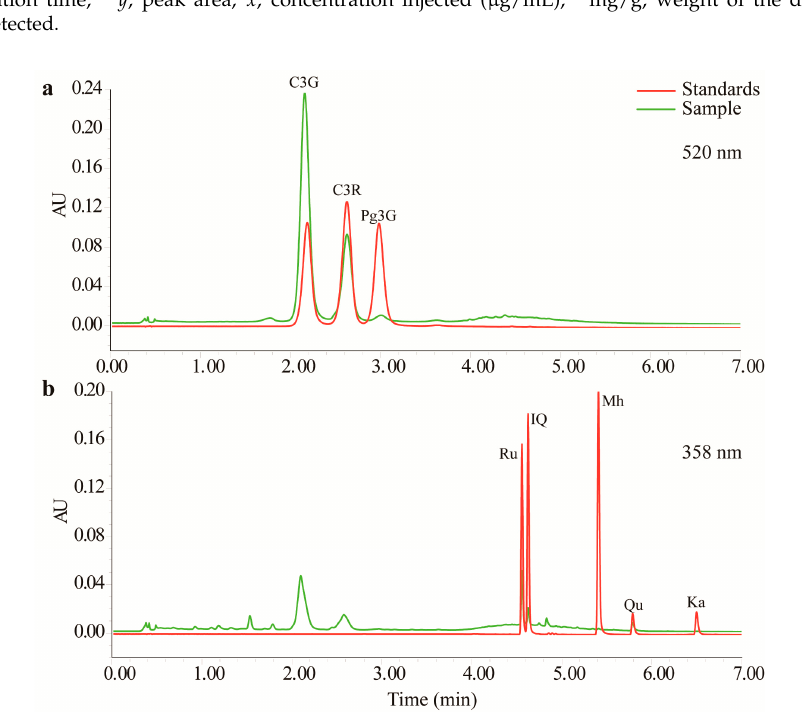
Figure 1. Chromatograms of anthocyanins ( a ) and flavonols ( b ) obtained by UPLC–TUV/QDa.